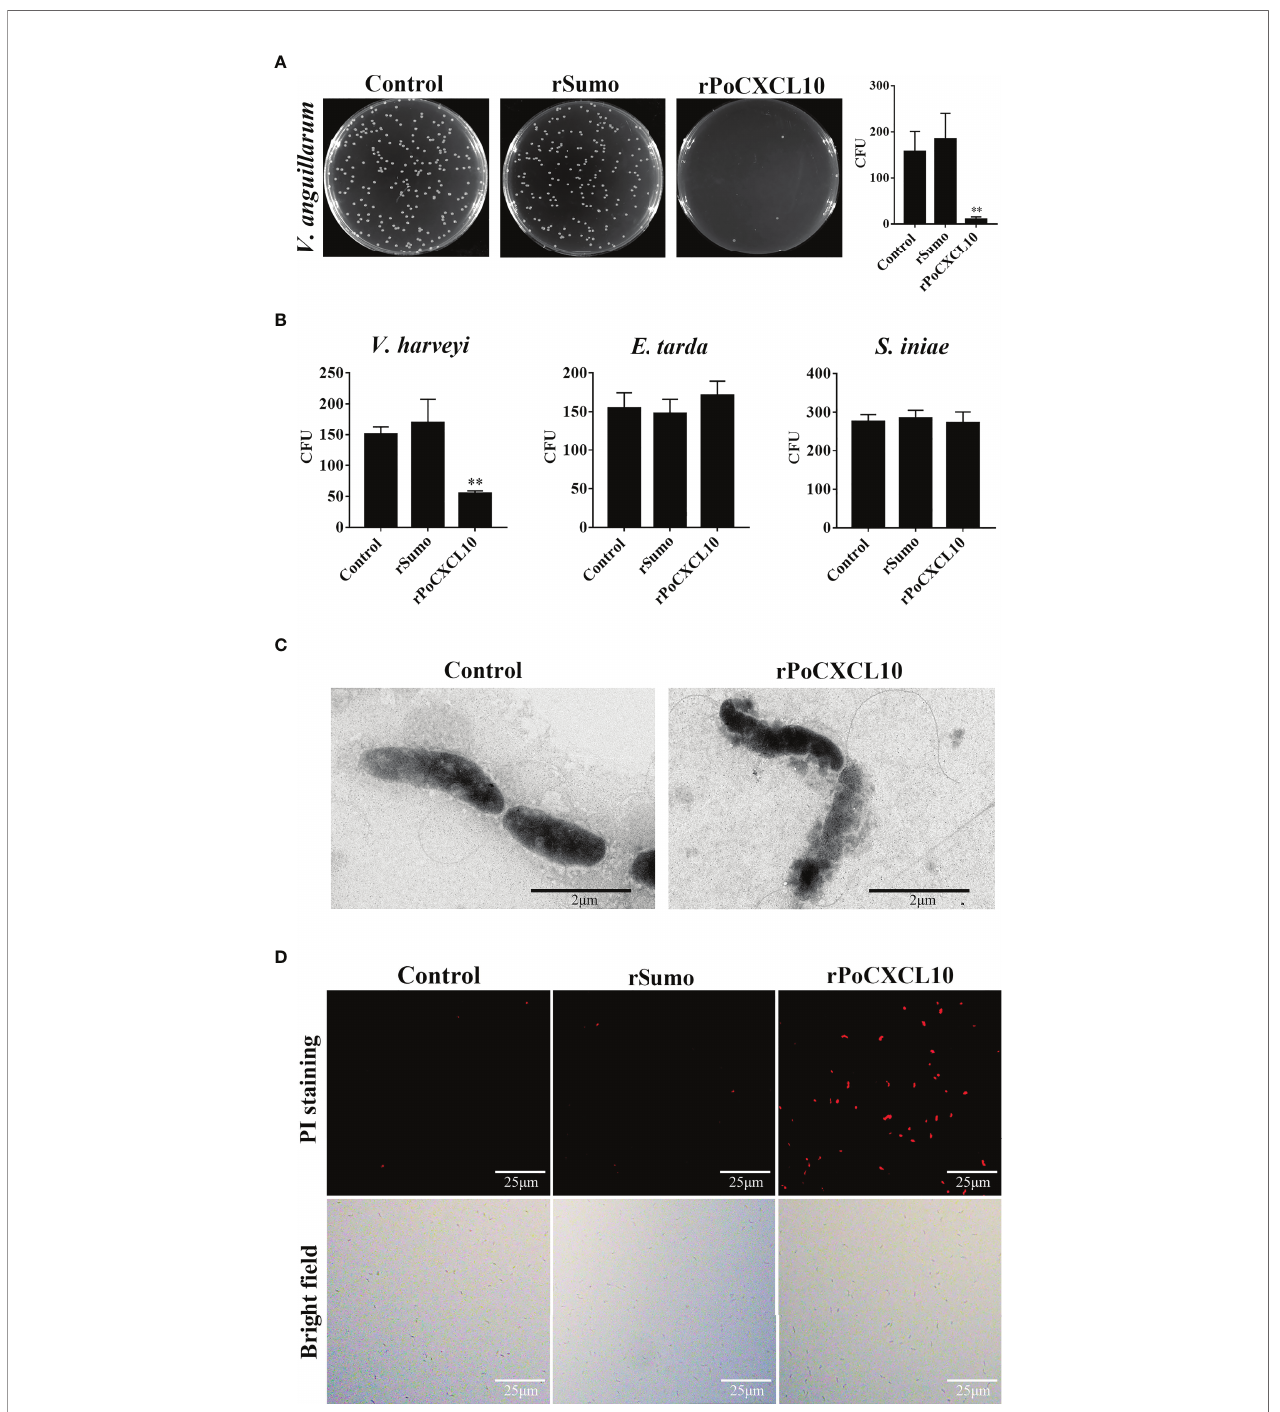
FIGURE 3 | The bactericidal activity of rPoCXCL10. (A) Vibrio anguillarum was incubated with rPoCXCL10 or rSumo or PBS (control) for 4 h. The bacterial cells were plated on Luria-Bertani (LB) plates and incubated at 28°C for 12 h. The number of colony-forming unit (CFU) was counted and shown on the right. (B) Vibrio harveyi , Edwardsiella tarda and Streptococcus iniae were incubated with rPoCXCL10 or rSumo or PBS as above, and bacterial survival was determined as above. (C) V. anguillarum was incubated with rPoCXCL10 or PBS (control) for 4 h and then examined with transmission electron microscopy. (D) V. anguillarum were incubated with rPoCXCL10 or rSumo or PBS (control) for 4 h, and then stained with propidium iodide (PI). The cells were observed with a fl uorescence microscope. Values are the means of triplicate experiments and shown as means ± SD. ** p <